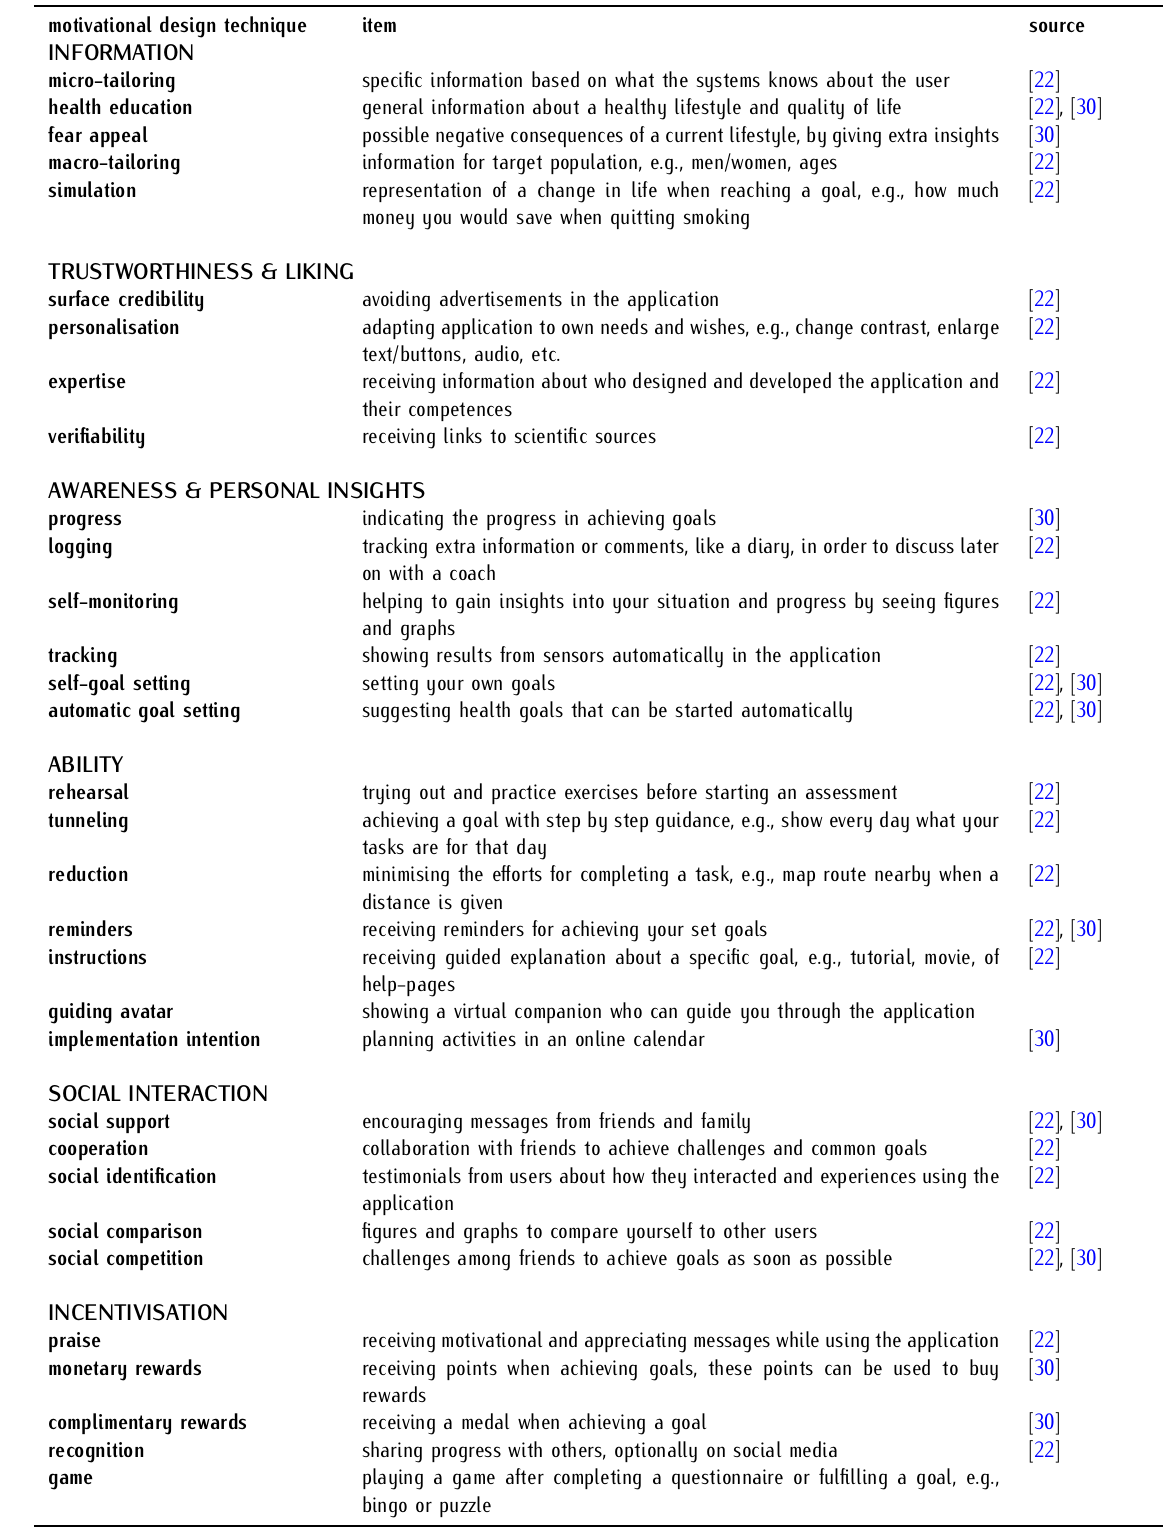
Table 2. Overview different motivational design